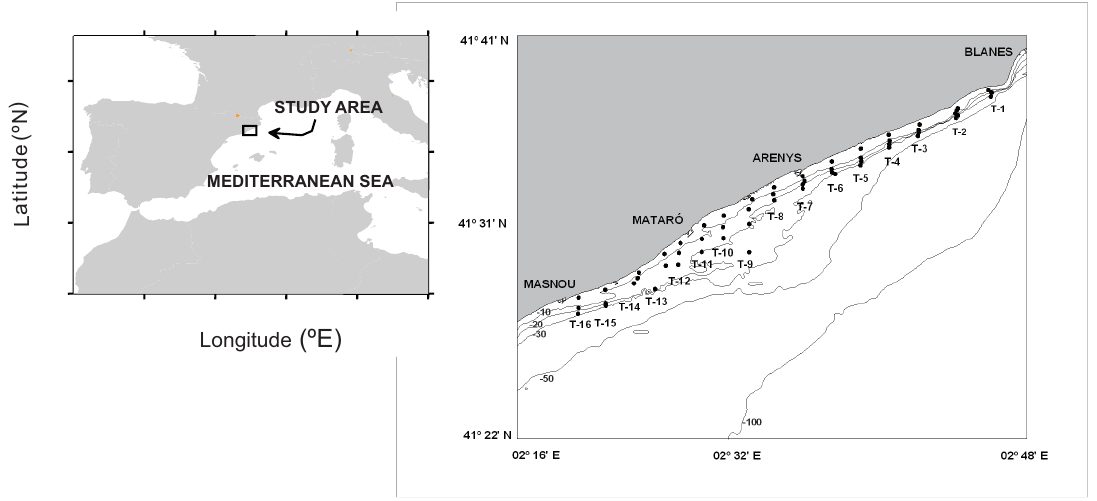
Fig . 1. – Location of the study area in the northwestern Mediterranean Sea, in the vicinity of